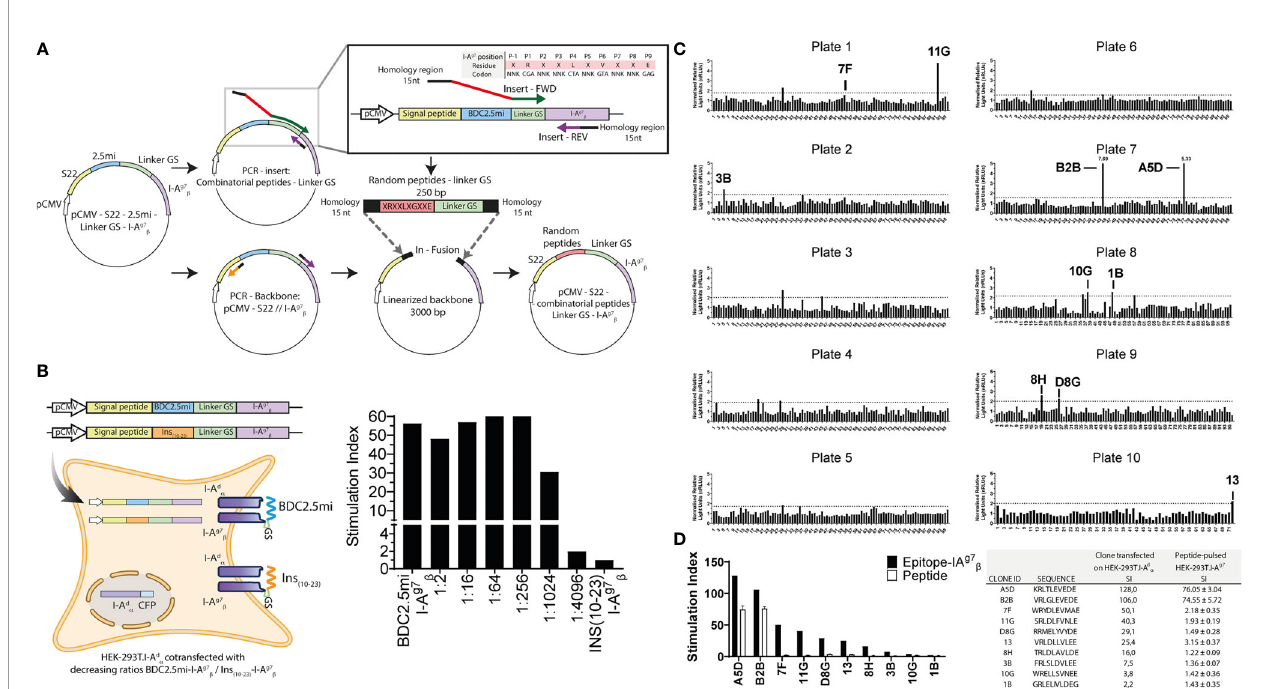
FIGURE 2 | Identi fi cation of 4.1-TCR agonists with a novel epitope discovery approach. (A) Cartoon depicting the cloning strategy of the combinatorial peptide-I-A g7 library. The combinatorial peptide-coding sequences were cloned immediately upstream of the I-A g7 b -coding sequences into an expression vector. To build the constructs carrying combinatorial peptide-coding sequences, peptide – linker fusions carrying short arms of homology to the desired plasmid integration site were generated by PCR using degenerate primers and then cloned in-frame to the PCR-linearized expression vector upstream of I-A g7 b , without intervening nucleotides, using the In-fusion HD reagent. We fi xed the P1, P4, P6, and P9 I-A g7 -anchor residues (P1=R, P4=V, P6=L, and P9=E) in the peptide-coding sequence but used degenerate “ NNK ” codon sequences for potential TCR contact residues (P-1, P2, P3, P5, P7, and P8). (B) The BDC2.5mi- I-A g7 b plasmid was co-transfected with increasing amounts of a similarly built Ins 10-23 - I-A g7 b -coding plasmid (from 1:0 to 1:4096 and 0:1 ratios, respectively) into HEK-293T cells constitutively expressing an I-A d a transgene (HEK-293T. I-A d a ) (left). The resulting cells were then used to trigger luciferase activity in BDC2.5-JurMA cells. Ratios lower than 1:1024 elicited luciferase activity (right), thus providing a sensitivity threshold for T-cell ligand screening. (C) Normalized relative light units (nRLUs; ratio of the RLU of each pool and the mean of RLU values of all pools tested in the same assay) induced in 4.1-JurMA cells by 96 × 10 pools of 500 clones each. RLUs higher that nRLU+3 standard deviations were considered positive. The 10 plasmid pools (out of a total of 17 positive pools identi fi ed) eliciting the highest nRLU values were deconvoluted to obtain individual agonistic mimotopes, identi fi ed in each of the plates. (D) HEK-293T-I-A g7 cells were either transfected with the agonistic plasmids from (C) or pulsed with the corresponding synthetic peptides (10 m g/ml) and then challenged with 4.1-JurMA cells. The panel on the left compares the stimulation indexes [ratio of luciferase units of the experimental condition vs. the negative control (BDC2.5mi)] obtained with plasmids vs. the corresponding peptides. B2B and A5D were identi fi ed as the most potent agonists. The panel on the right provides absolute